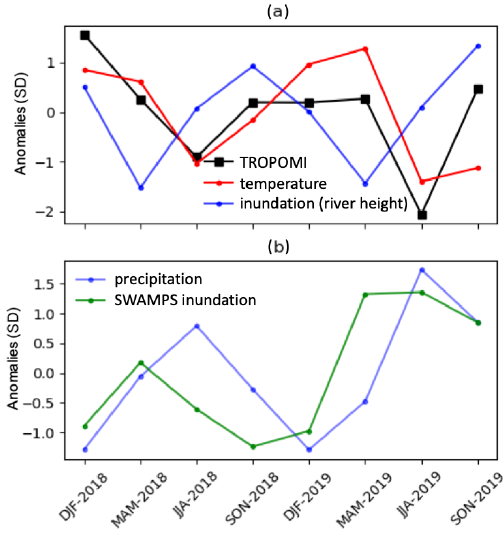
Figure 7. Seasonal anomalies in SSWR. (a) TROPOMI emis- sions estimates, ERA5 temperature and inundation extent from river height measurements are shown. (b) Local precipitation and SWAMPS inundation extent data are shown. All values are ex- pressed in units of standard deviation. The correlation coeffi- cients ( R ) of TROPOMI emissions with temperature, river height, SWAMPS and precipitation are 0.49 and 0.24, − 0.33 and − 0.67,